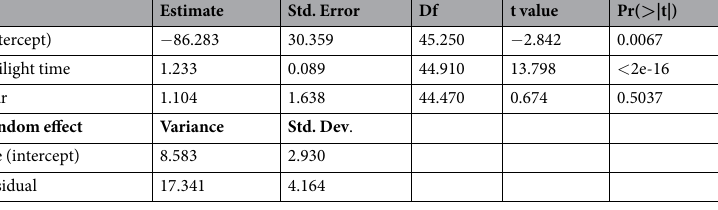
Table 2. LMM output for the effects of twilight time on the daily timing of dawn-song. There is a significant effect of twilight time on the daily onset of